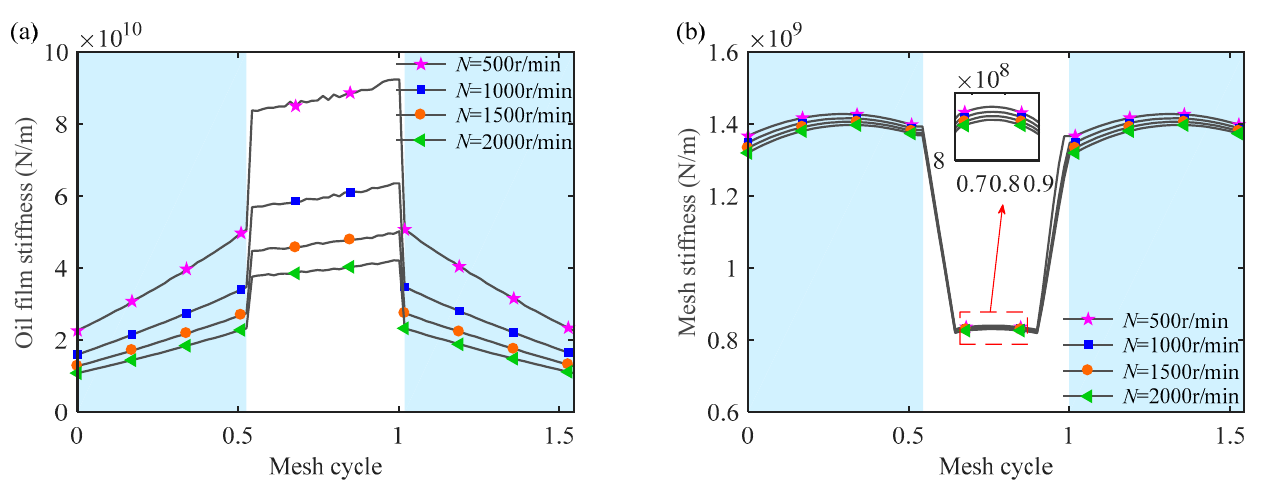
Figure 14. OFS and TVMS of gear under different rotational speeds: ( a ) OFS; ( b ) TVMS.